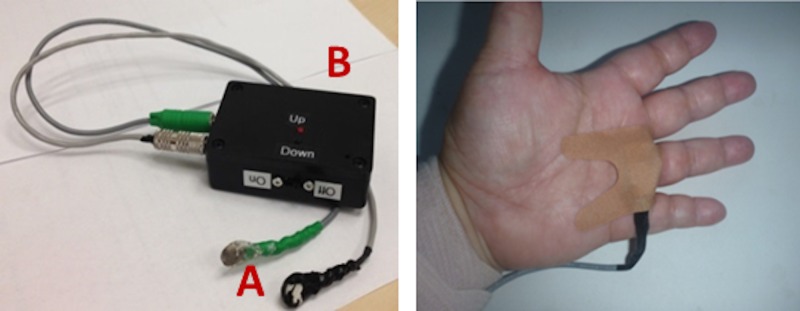
Vibration Device: The vibration device consists of two components: (A) a stimulation device, containing a low voltage battery that powers the vibration motor through flexible cables, and (B) small vibrating disks (approximately 10 mm in diameter), which are taped to the skin over proprioceptive fibers in the hand and foot.